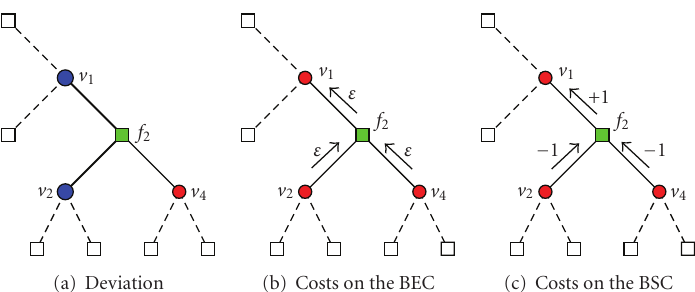
Figure 7: A small portion of a deviation on a computation tree illustrating the impact of stopping set deviations on the BEC and BSC